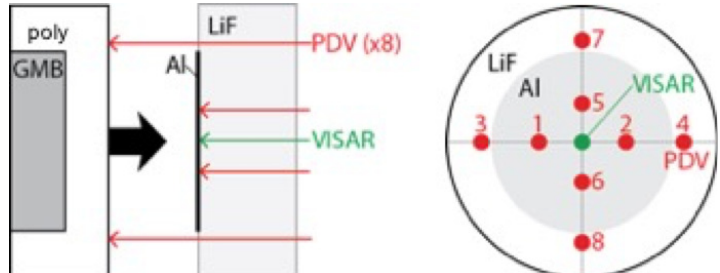
Figure 9. Deep-release configuration developed to access release pathways from states above the dissociation threshold on the principal Hugoniot ( P H > 25 GPa). Particle velocities measured at the interface with dual VISAR and multiple points of PDV were used to characterize the shock state and release